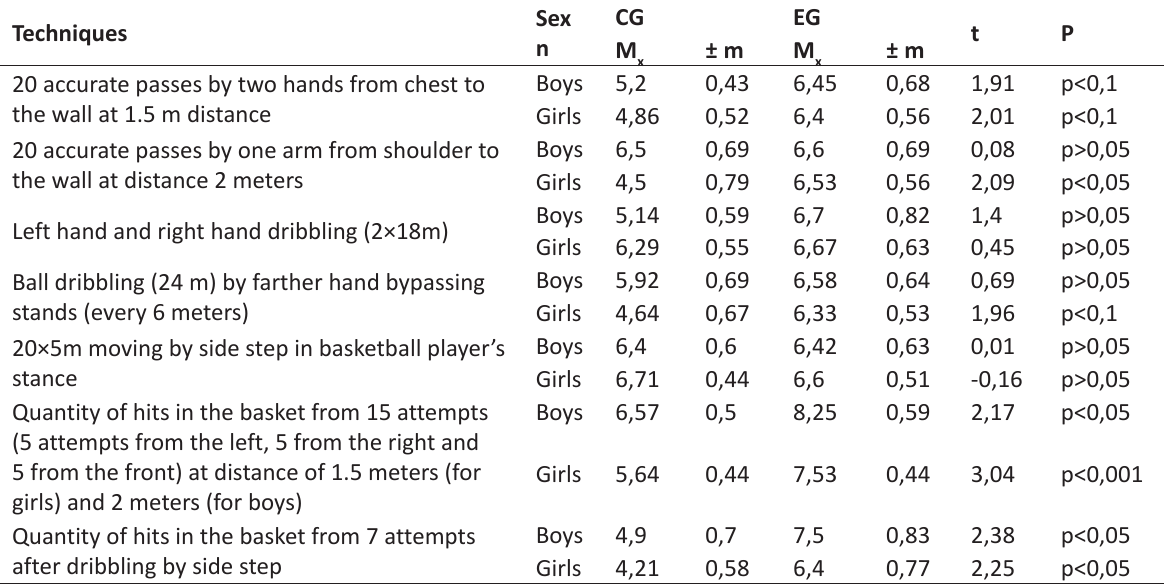
Table 3. Quickness and efficiency of basketball techniques’